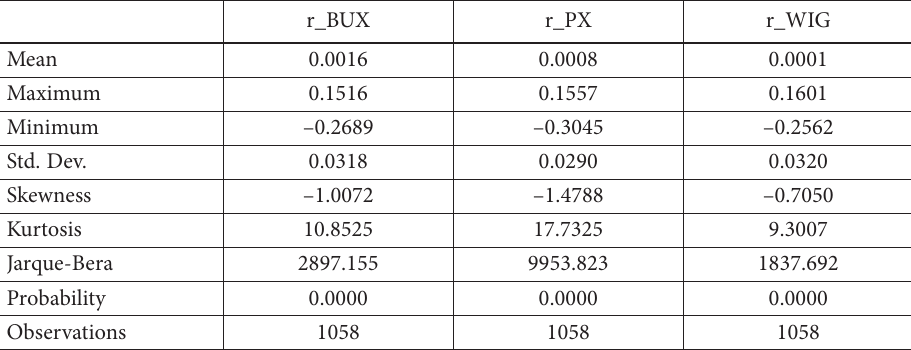
Table 1. Descriptive statistics of stock returns (source: own calculations in EViews)